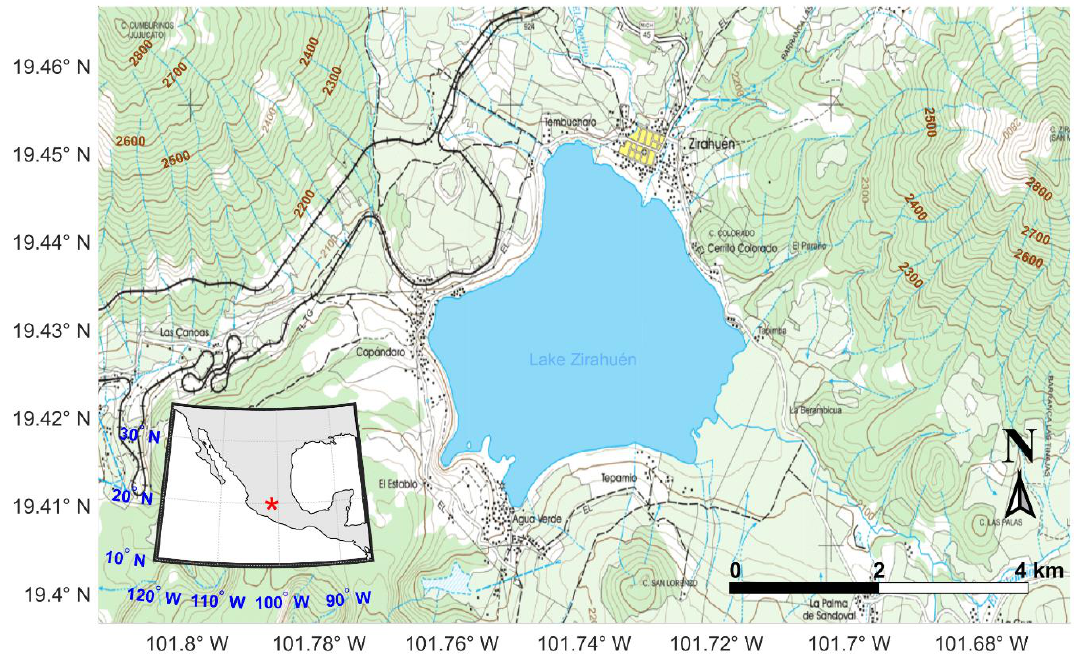
Figure 1. Study area with the topography of the surrounding region. Elevation contour lines are at 20 m intervals, marked at 100 m intervals. Inset map shows the location of the study area within Mexico. The red mark indicates the location of Lake Zirahuén (Source: © OpenStreetMap contributors and GIS user Community).